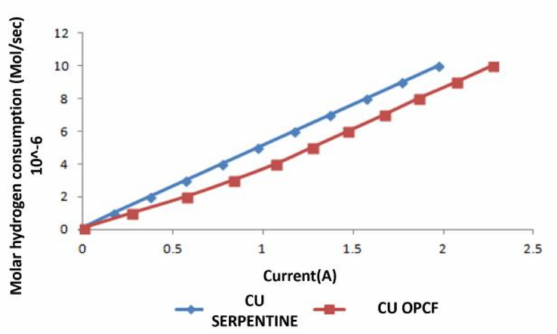
Figure 9. Hydrogen consumption (Cu bipolar plate material).